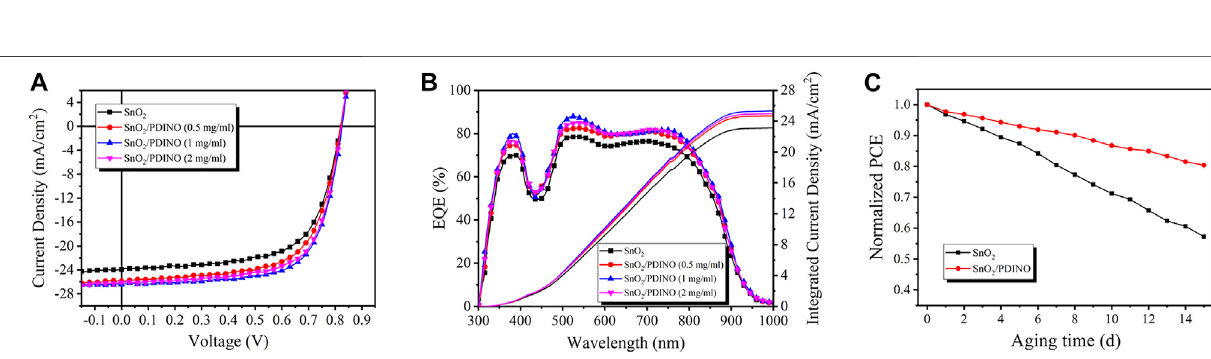
SnO 2 /PDINO ETLs, with the device structure shown in Figure 1B . The J-V curves are recorded and shown in Figure 4A . The performance metrics of the OSCs are